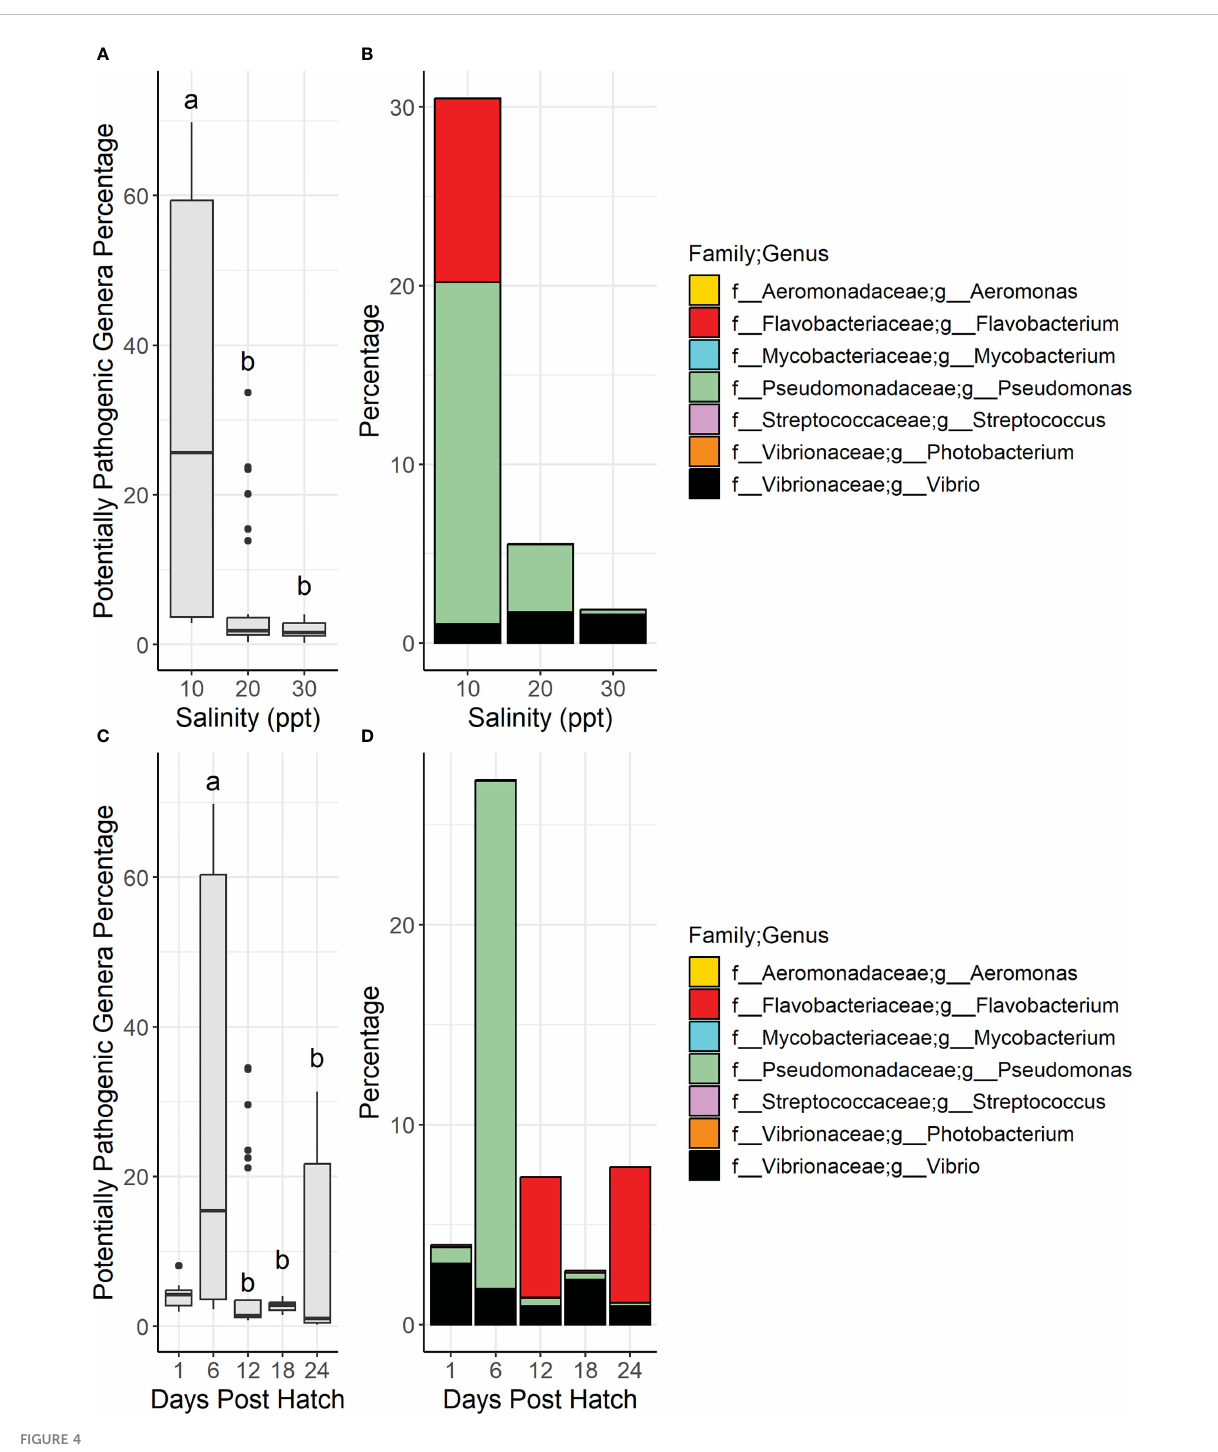
FIGURE 4 Boxplots show the total relative diversity of the nine potentially pathogenic genera in water samples summarized by salinity (A) and days post hatch (C) . In the boxplot fi gures (A, C) bars denote largest and smallest values within 1.5 times the interquartile range with dots representing values outside that range, middle line is the medium, and ends of boxes are the fi rst and third quartiles. Letters above the boxplots indicate results of pairwise Dunn testing with Benjamini-Hochberg adjusted p-values. If there is a shared letter between boxplots, it means that they were statistically similar (Benjamini-Hochberg adj. p-value > 0.05). Stacked bar graphs of the total relative diversity of the potentially pathogenic genera in larvae samples summarized by salinity (B) and days post hatch (D) . Genera and their associated families are represented by